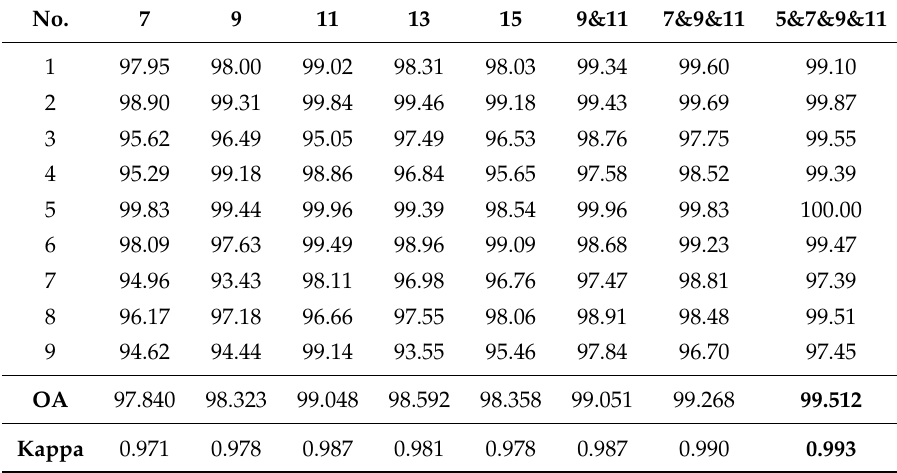
Table 7. Class-specific accuracies (%), OA (%) and Kappa coefficients generate by the ASSP-SCNNs on PaviaU dataset. Here we train the ASSP-SCNN by a constructing 3D sample-pair set according